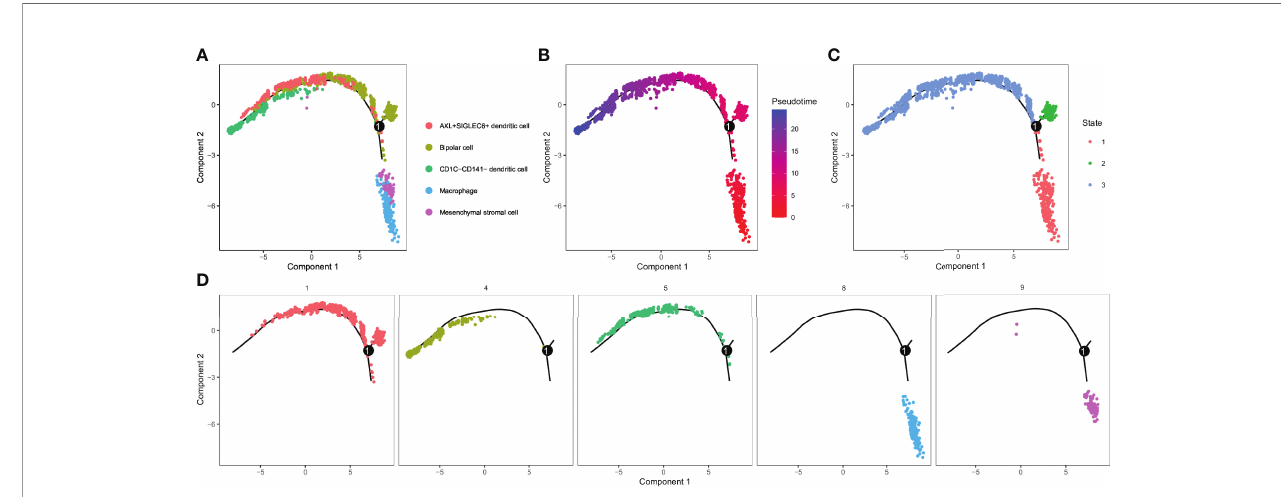
FIGURE 6 | Identi fi cation of 3 subsets by cell trajectory analysis of fi ve cell clusters. (A – D) Cell trajectory and pseudotime analysis for the fi ve cell clusters (C1, C4, C5, C8, and C9) signi fi cantly correlated with overall survival of